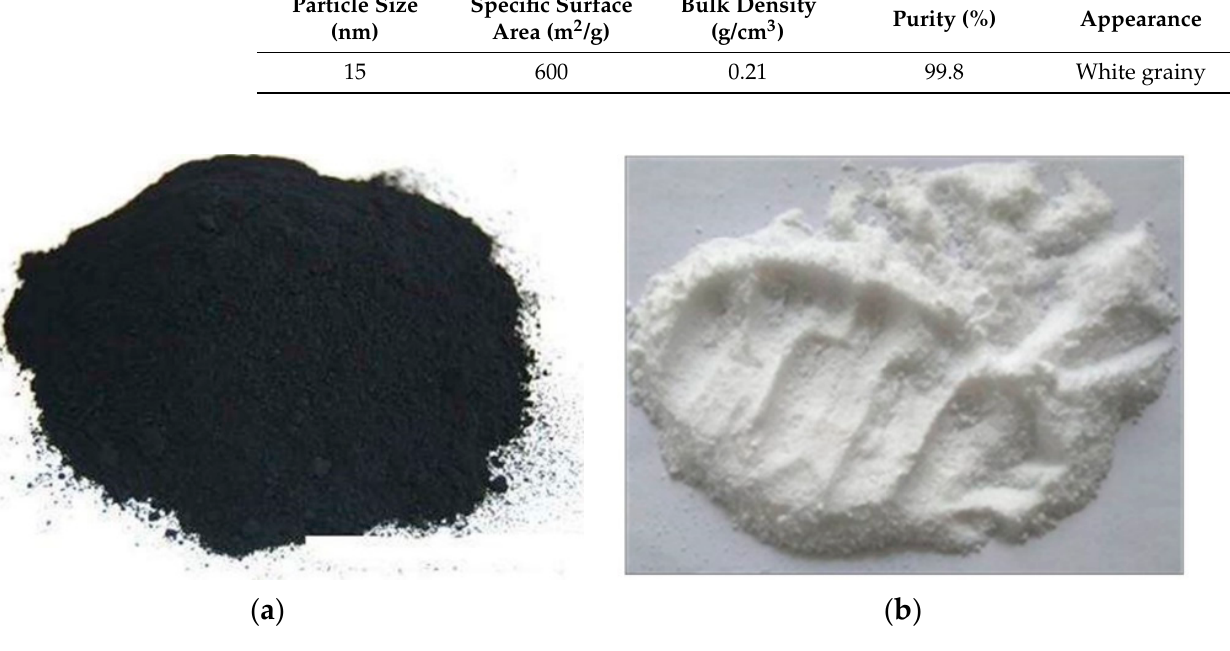
Figure 1. Additive. ( a ) Toner; ( b ) nano ‐ SiO 2.